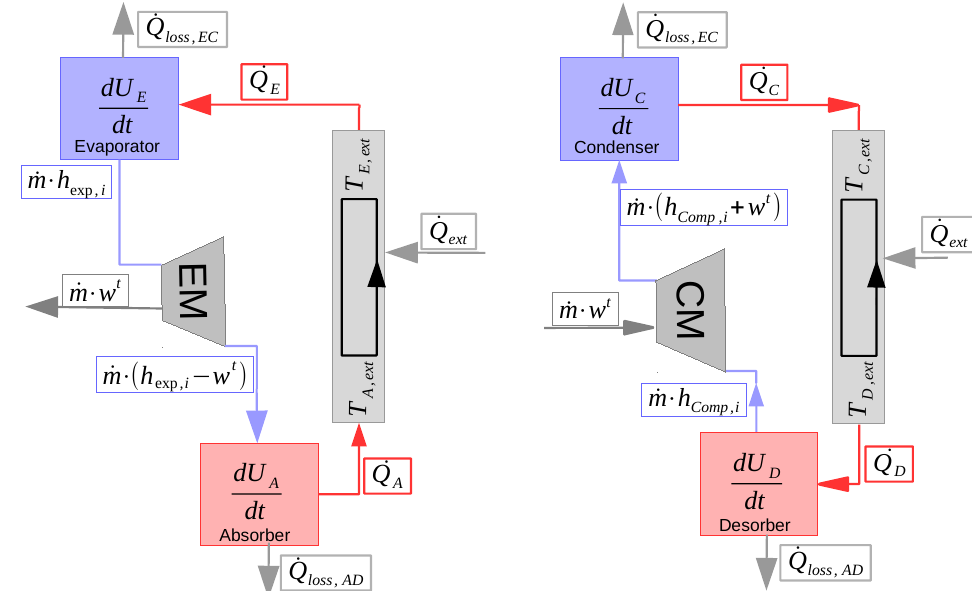
Figure 4. System configuration (B): Indirectly coupled HXs—mechanical discharging ( left ), mechani- cal charging ( right ).